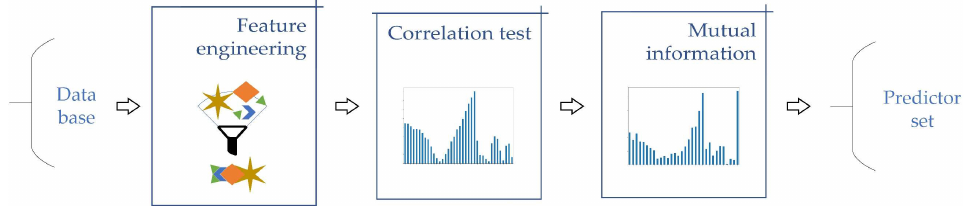
Figure 2. Proposed solution for extracting features and selecting the most important ones.